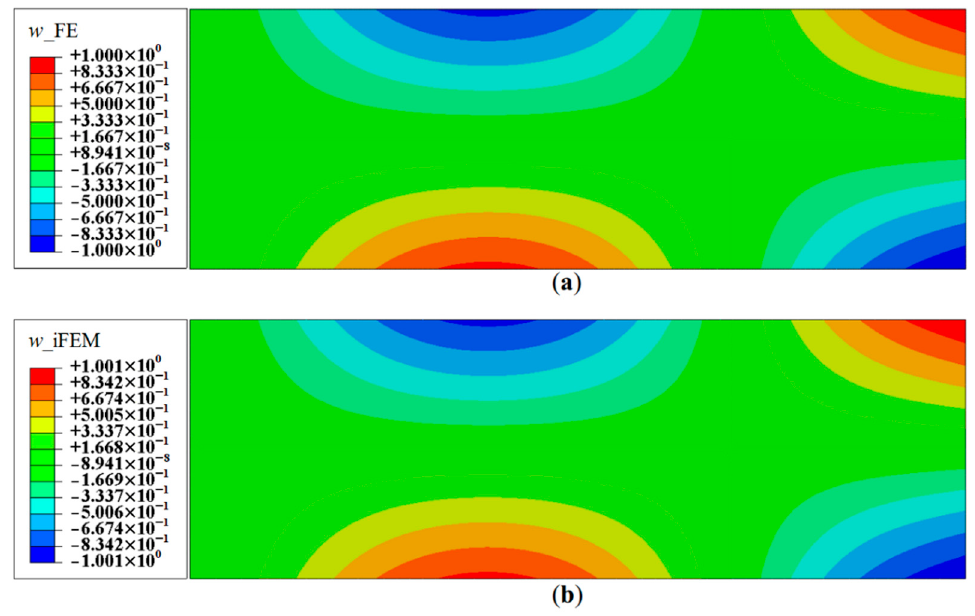
Figure 19. Contour plots of deflection for Mode 5: ( a ) FE results; and ( b ) iFEM results using full-field strain data (Configuration-D).